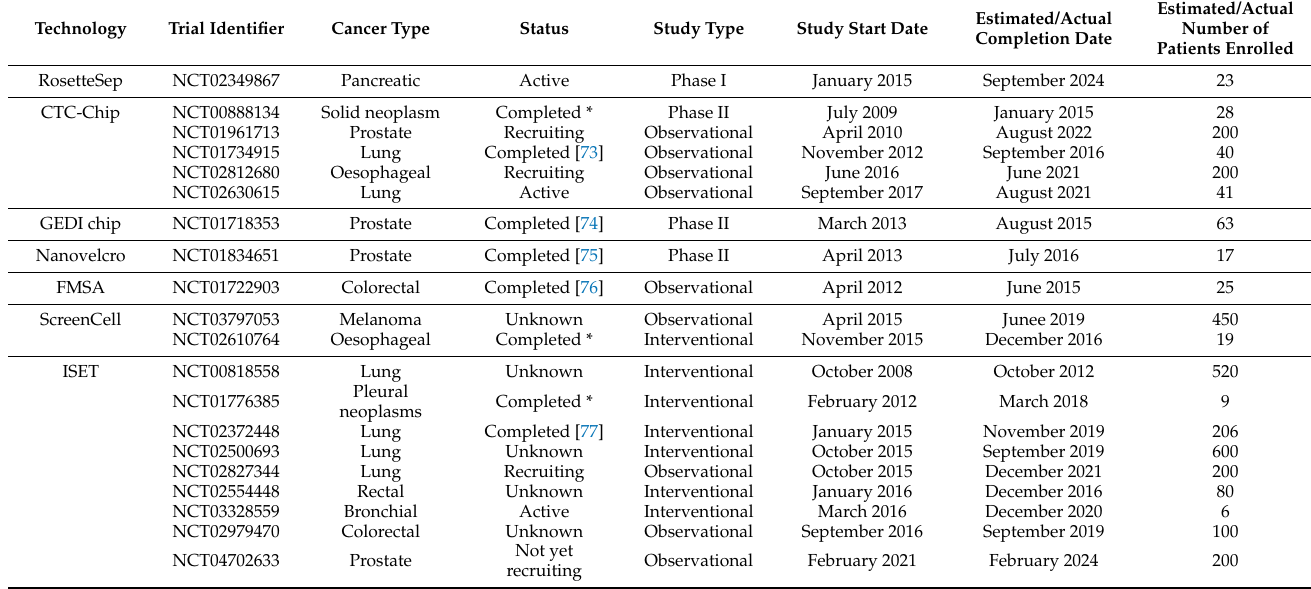
Table 2. Clinical trials including CTC analysis using different CTC enrichment technologies (clinicaltrials.gov; accessed on 20 February 2021). Cancer type, study type and status, study start date and estimated or actual study completion date and estimated or actual number of patients enrolled are also